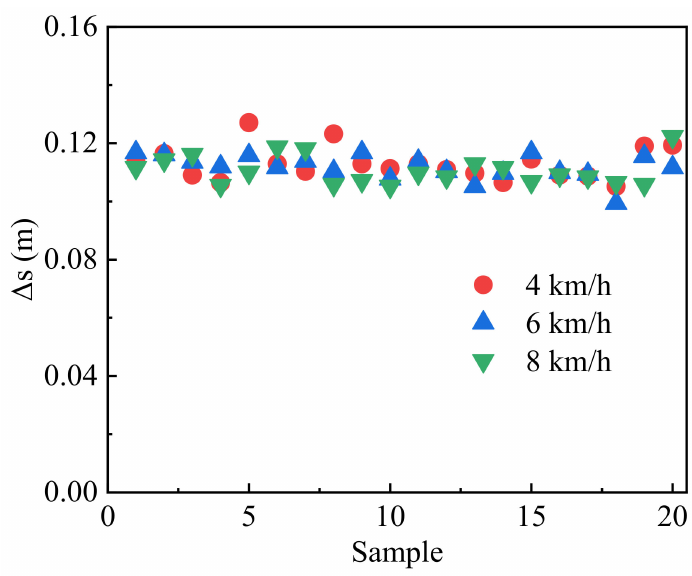
Figure 10. The distance between the seeds on the seed bed and photoelectric sensor in the horizontal direction ( ∆ s ) of 20 samples at different forward speeds.